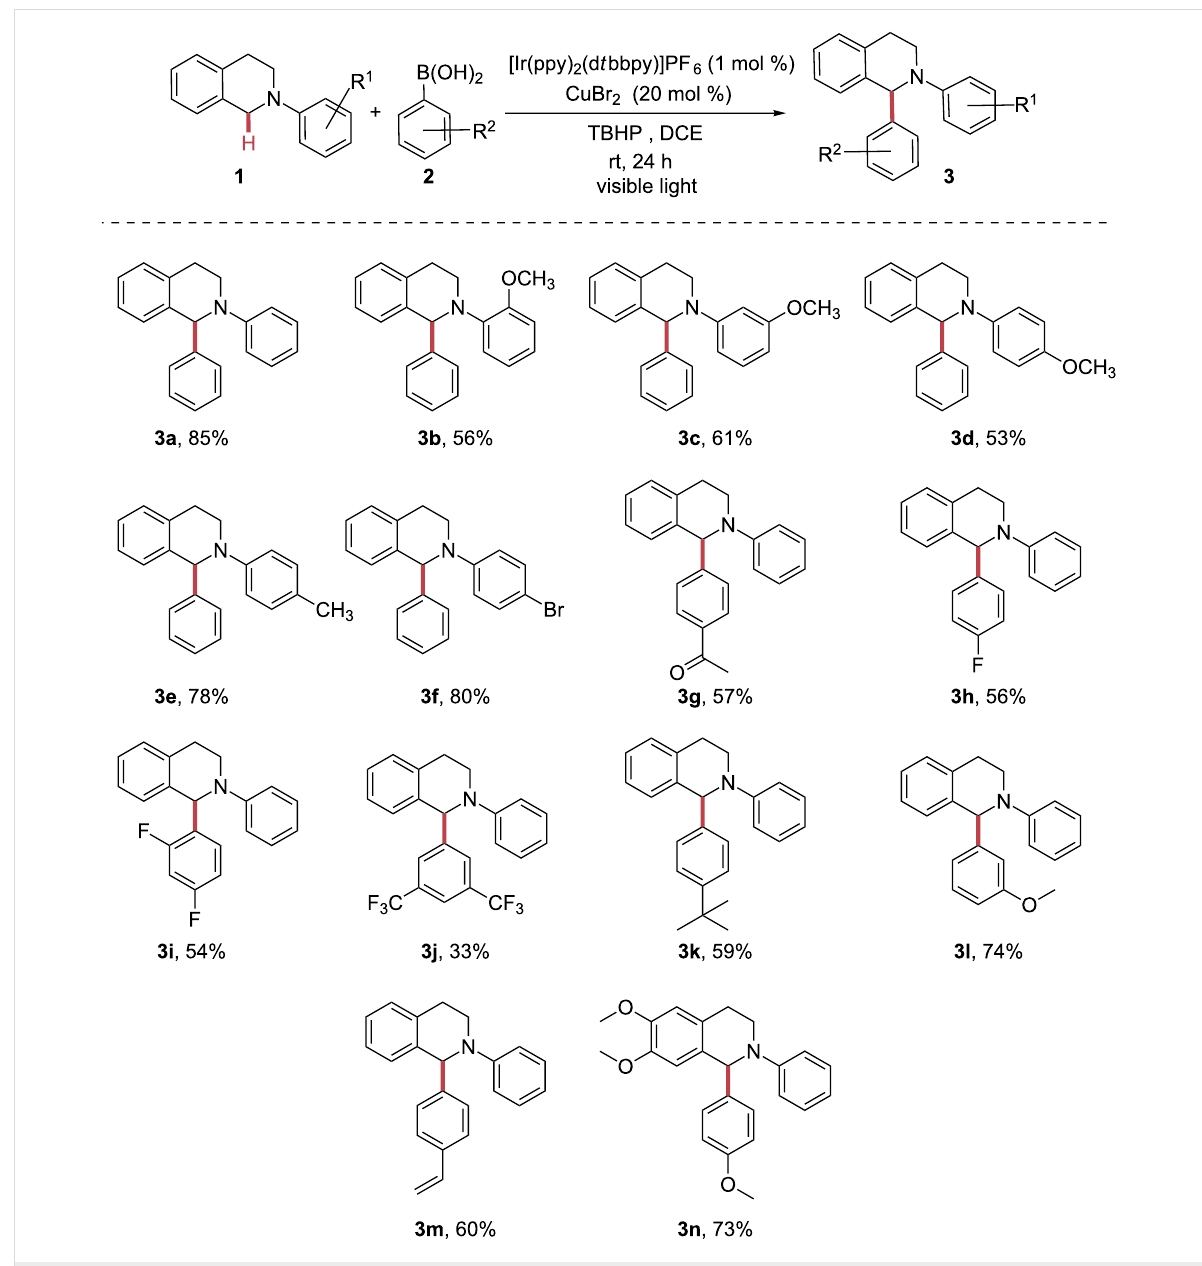
Figure 1: Reaction scope. Reaction conditions: THIQs (0.10 mmol), arylboronic acid (0.30 mmol), TBHP (0.2 mmol), [Ir(ppy) 2 (d t bbpy)]PF 6 (0.001 mmol), CuBr 2 (0.02 mmol), DCE (0.5 mL), under argon